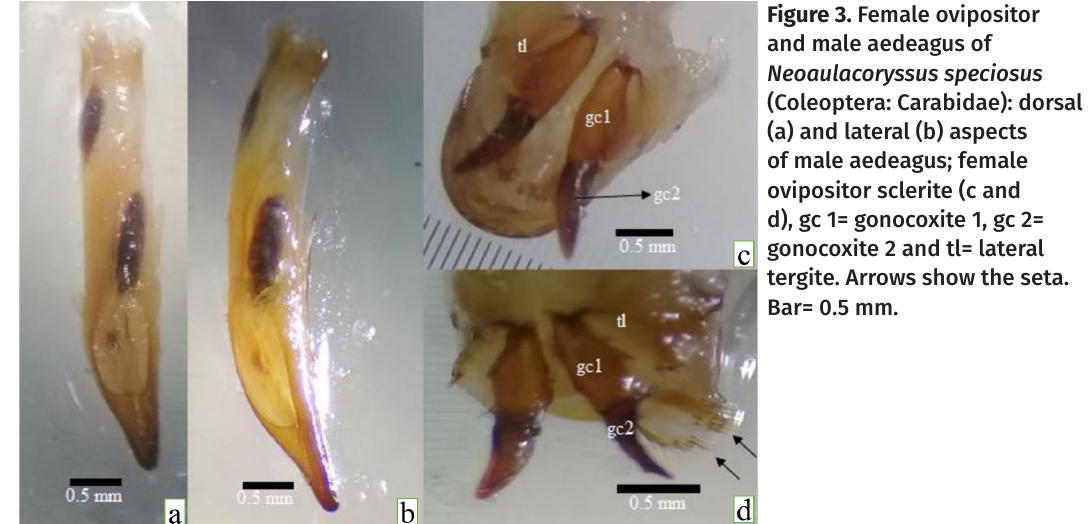
Figure 3. Female ovipositor and male aedeagus of Neoaulacoryssus